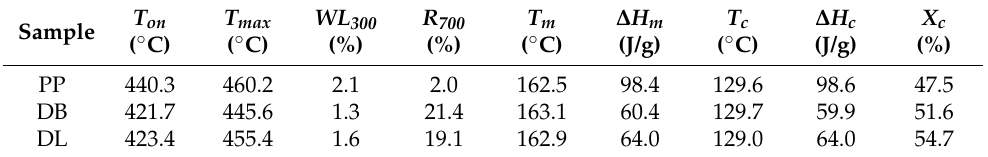
Table 5. TGA and DSC data for PP and PP hybrid composites obtained with the selected masterbatches.